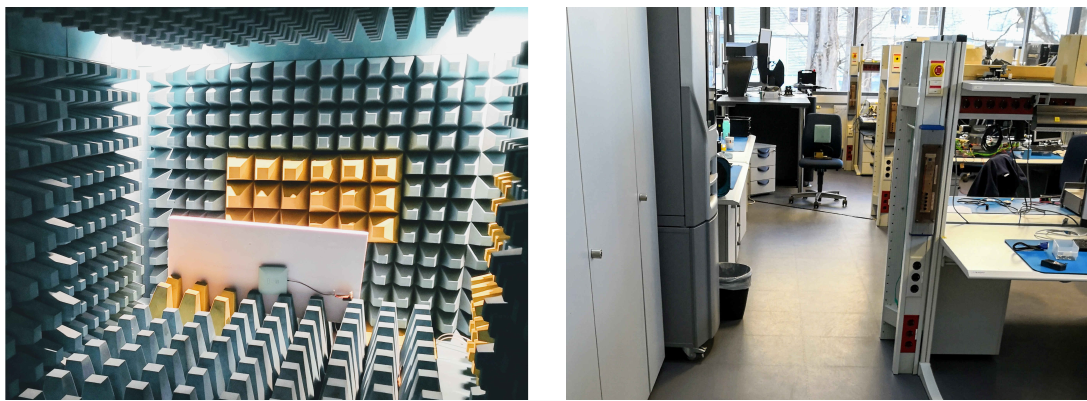
Figure 7. Measurement setup M2. On the left side, the actuator has been placed in the anechoic chamber and on the right side for multipath propagation in a